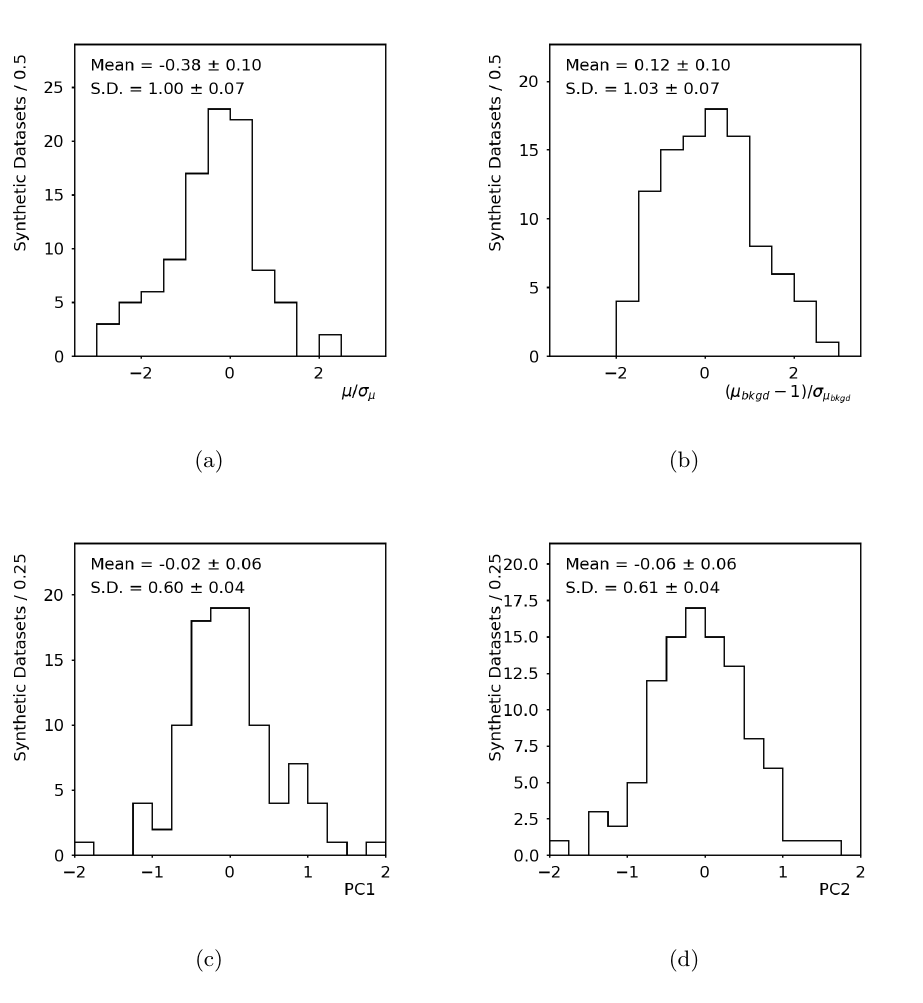
Figure 18 . The pull distribution for (a) the signal strength and (b) the background normalisation. Furthermore, the post-fit values of the nuisance parameters associated with (c) the leading and (d) the sub-leading background shape uncertainties, are also presented. These results are extracted from fits to the synthetic datasets described in section